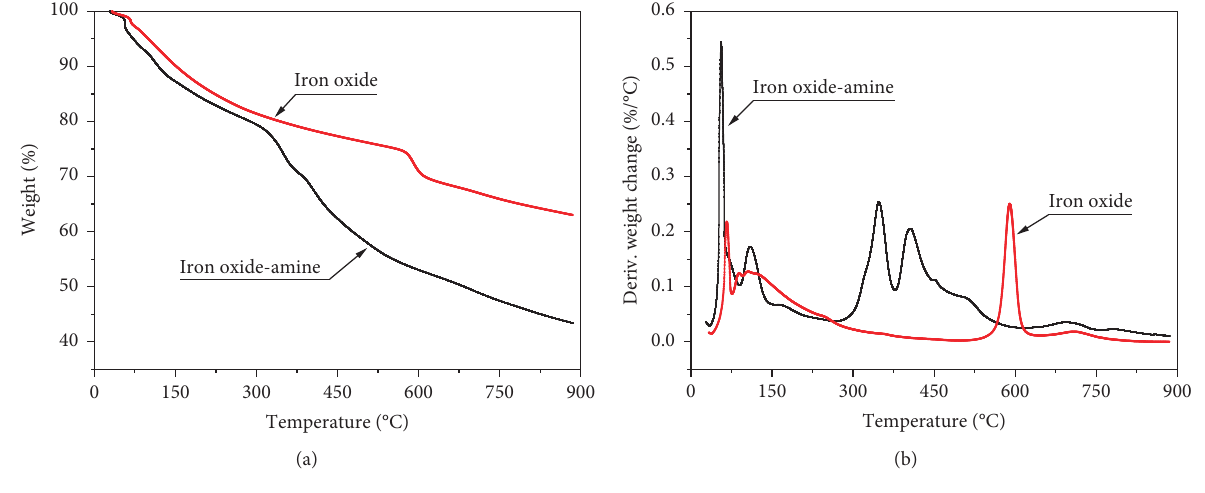
Figure 3: (a) TG and (b) DTG curves of ferric oxide-amine.